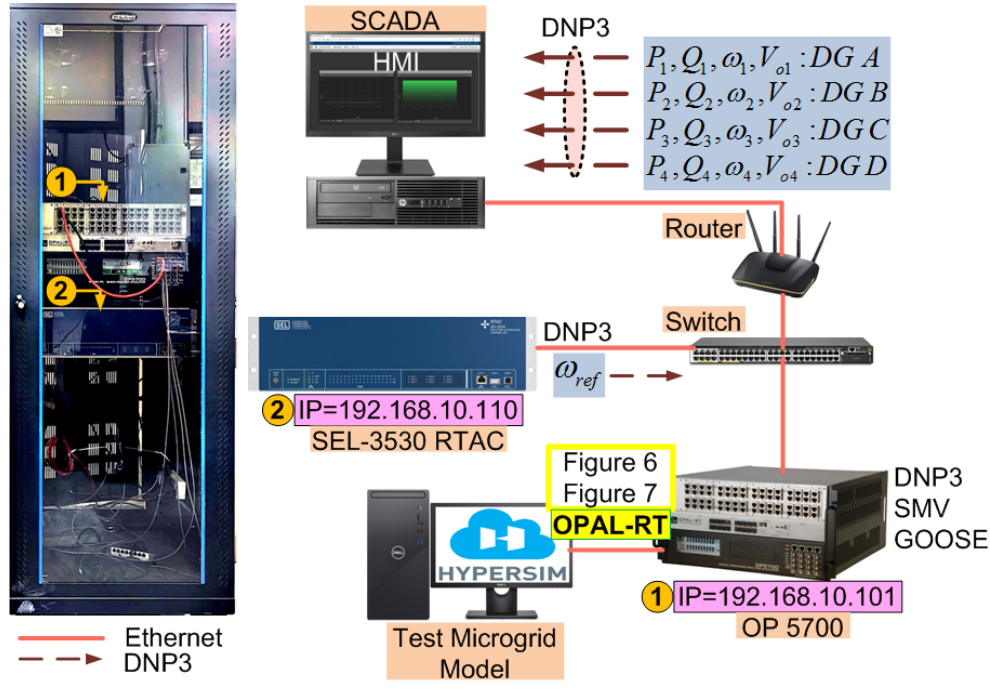
Figure 5. Testbed